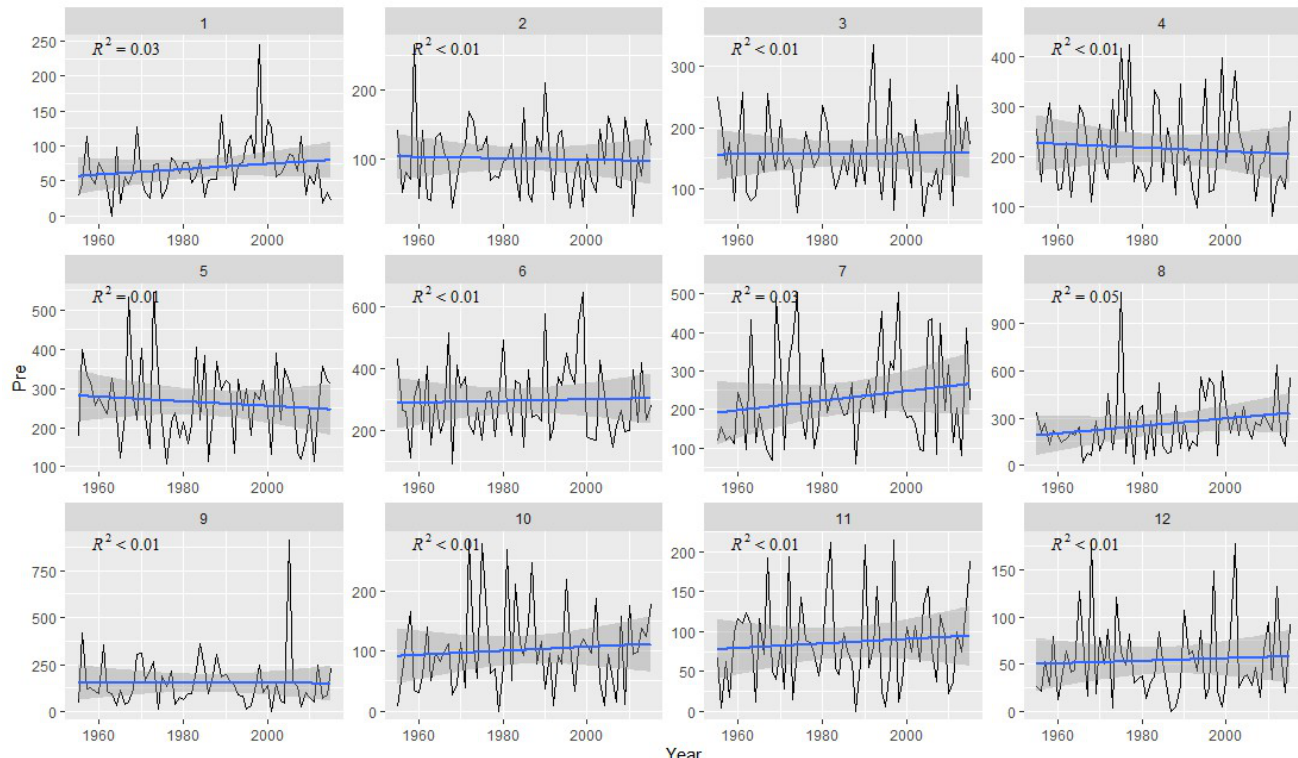
Figure A3. Climate trends of monthly precipitation during 1955–2014.